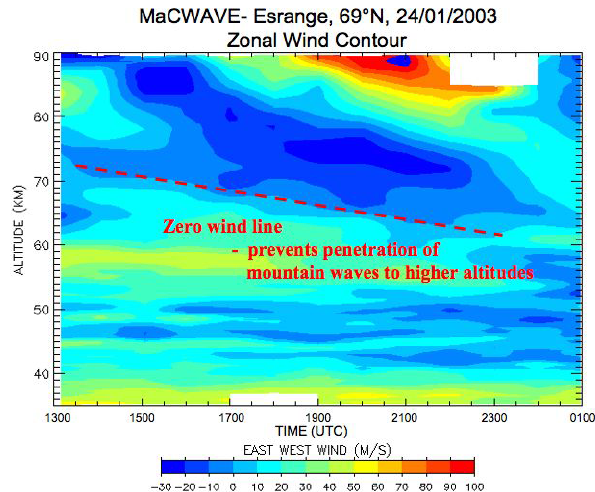
Fig. 12. Time contour of zonal winds on the night of 24 January 2003 (Salvo 1) during the MaCWAVE winter program as deter- mined from the FS data. Eastward winds are positive. A wind reversal is seen to progress from 70km down to 60km during the